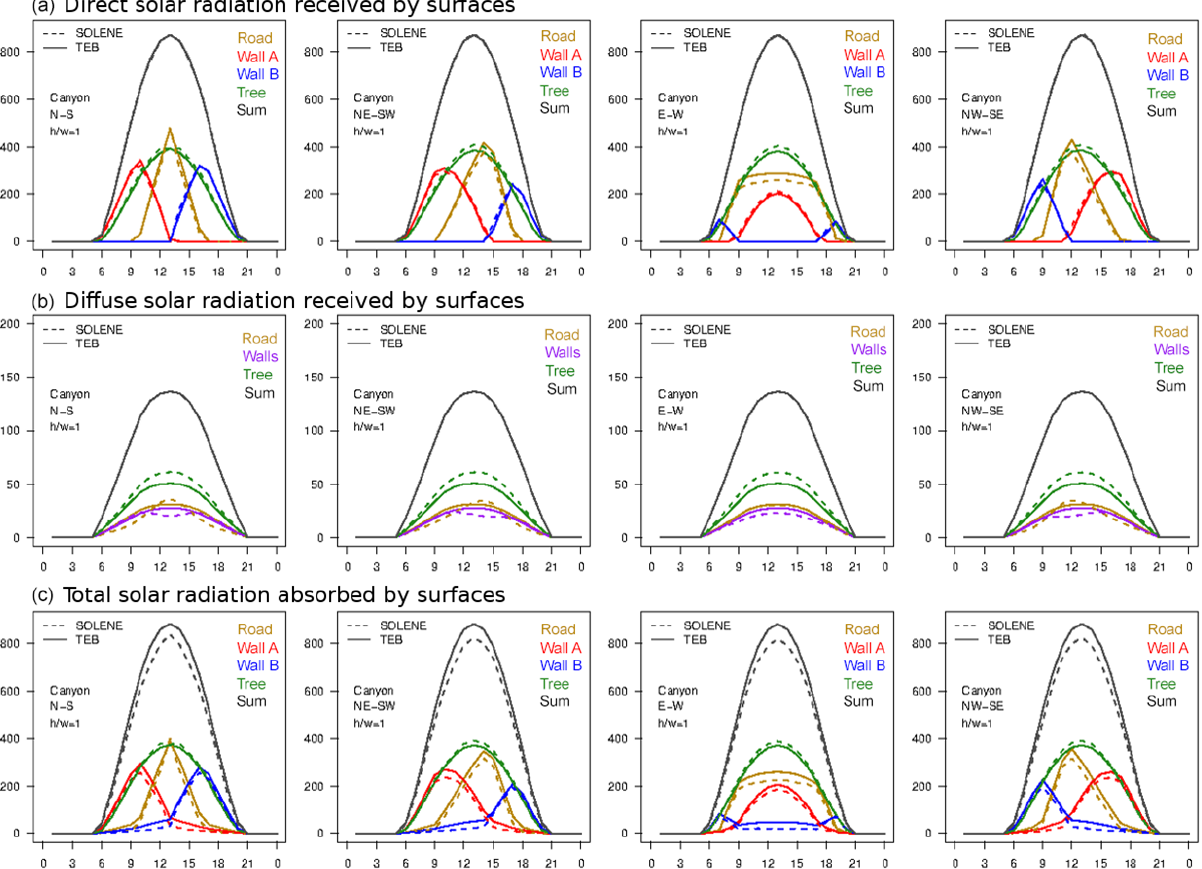
Figure 6. Comparison of TEB and SOLENE simulations of hourly direct (top) and diffuse (middle) solar radiation fluxes (Wm − 2 ) received by urban facets before multiple reflections, and total shortwave radiation fluxes (Wm − 2 ) absorbed by urban facets after inter-reflections (bottom) for urban canyons with vegetation. The results are presented here only for the aspect ratio equal to 1 and for the four street orientations during a summer